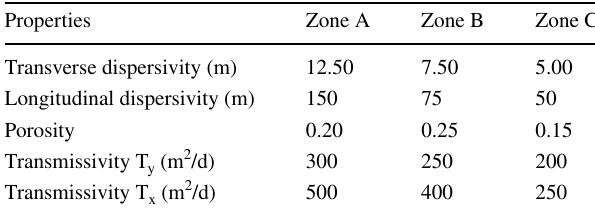
Table 1 Hydrogeologic data used for flow and transport model Properties